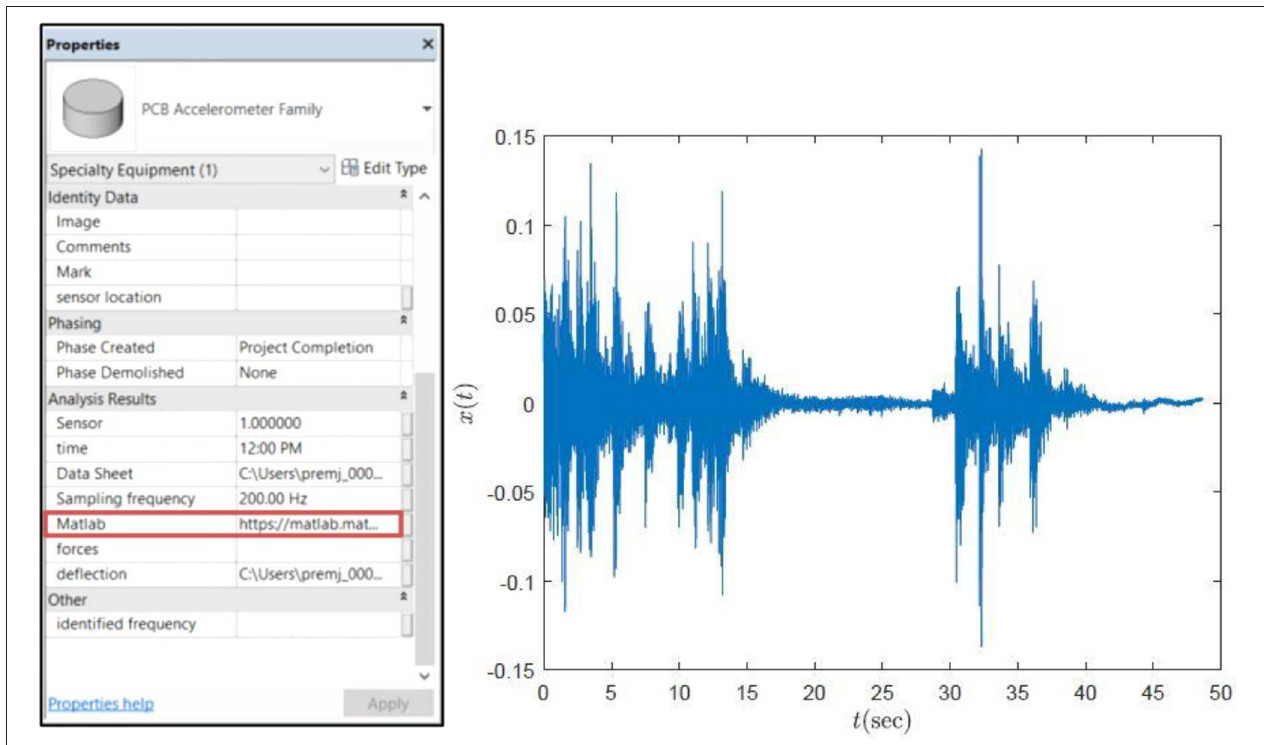
FIGURE 10 | Time history of the measured response at the mid-span of the bridge.